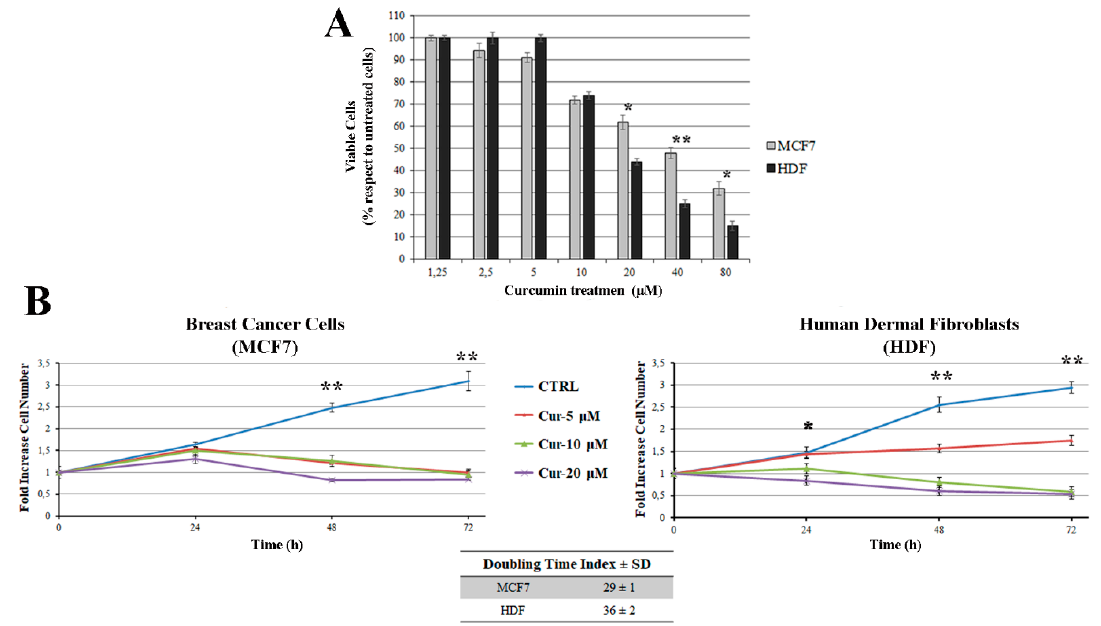
Figure 1. Effect of curcumin treatment on cell growth and cell viability in human dermal fibroblasts (HDFs) and breast cancer cells (MCF7). ( A ) Cell viability was determined by an MTT assay after exposure to an increasing concentration of curcumin for 24 hours. ( B ) Cell growth represented as the fold increase in the number of viable cells over 24, 48, and 72 h for HDF and MCF7 cells exposed to 5, 10, and 20 µM of curcumin. The calculated doubling time index is shown in the table. The values in the figures are expressed as the mean ± SD of five independent experiments, each performed in and 80 µM curcumin treatments. In both cell lines, significant differences in cell growth between the control cells and the curcumin-treated cells were observed (at 48 h and 72 h for all used doses and at 24 h for the HDF cell line in the 10 µ M and 20 µ M curcumin treatments). * p < 0.05 and ** p < 0.001.